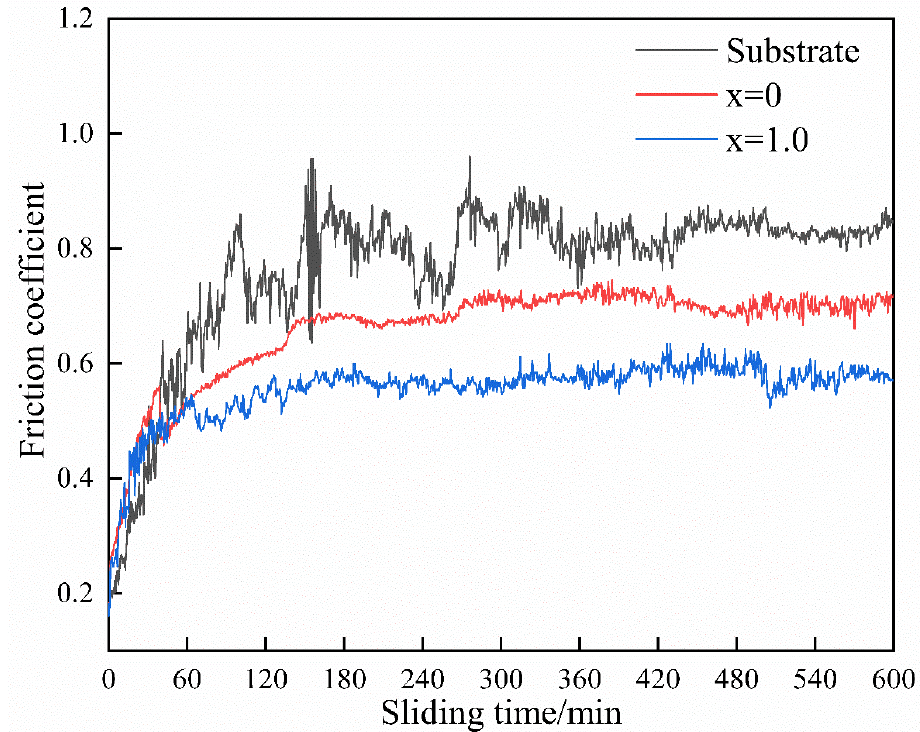
Figure 9. Variation of the friction coefficient of the samples with sliding time.